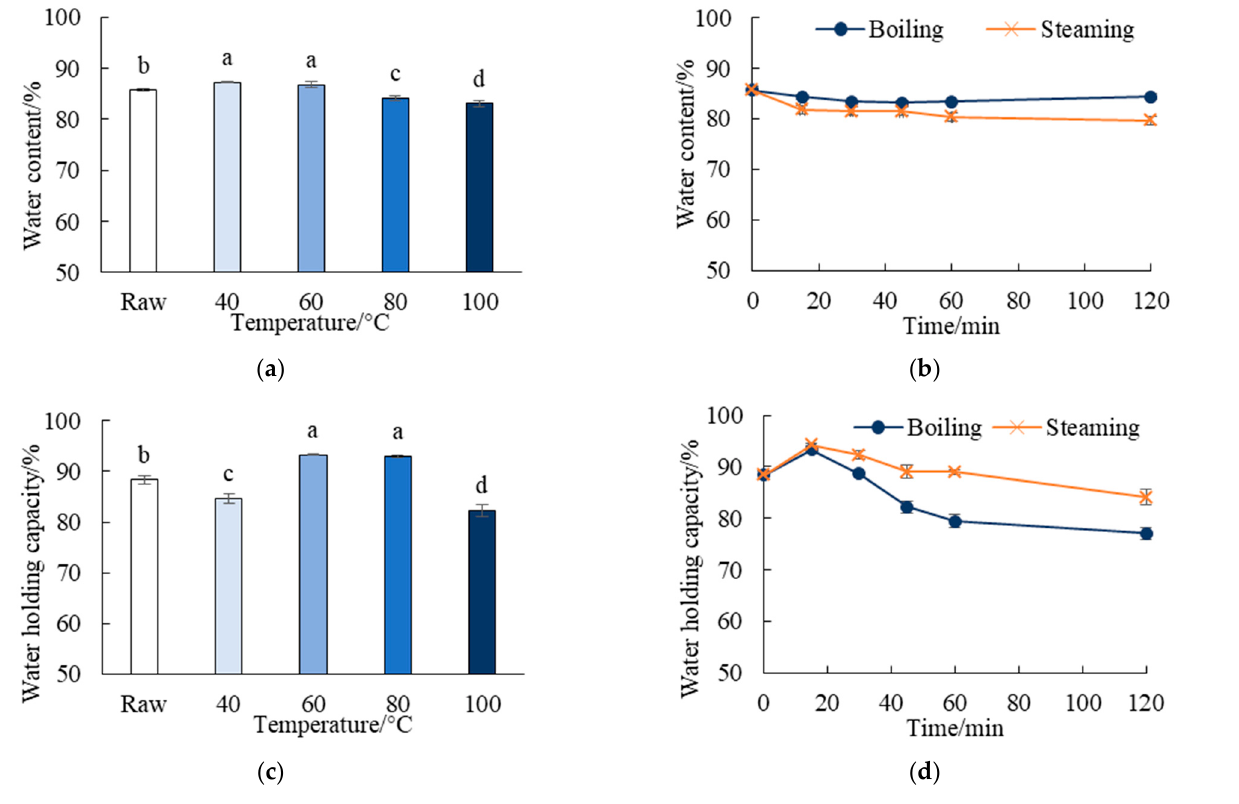
Figure 2. Water content and WHC of C. frondosa as affected by various heat treatments, ( a ) comparison of water content ( a ) and WHC ( c ) during cooking for 45 min at different temperatures (40, 60, 80, and 100 °C), and comparison of water content ( b ) and WHC ( d ) after boiling and steaming at 100 °C for 0–120 min. Different letters (a, b, c, d) indicate significant differences between groups as determined via one-way ANOVA ( p < 0.05).